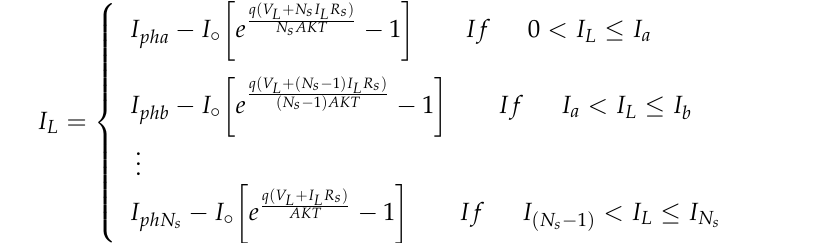
Table 2. The maximum power point under different shadow distribution cases.